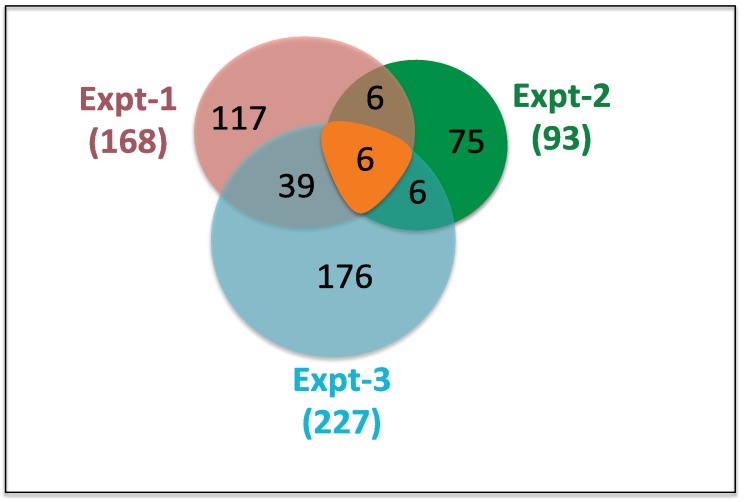
Summary of mass-spec results.LC-MS data analysis from three independent experiments is shown. In parenthesis the numbers proteins (168, 93 and 227), which were enriched or exclusively present in ERM-WT compare to ERM-core. Only six proteins met these criteria in all three experiments.